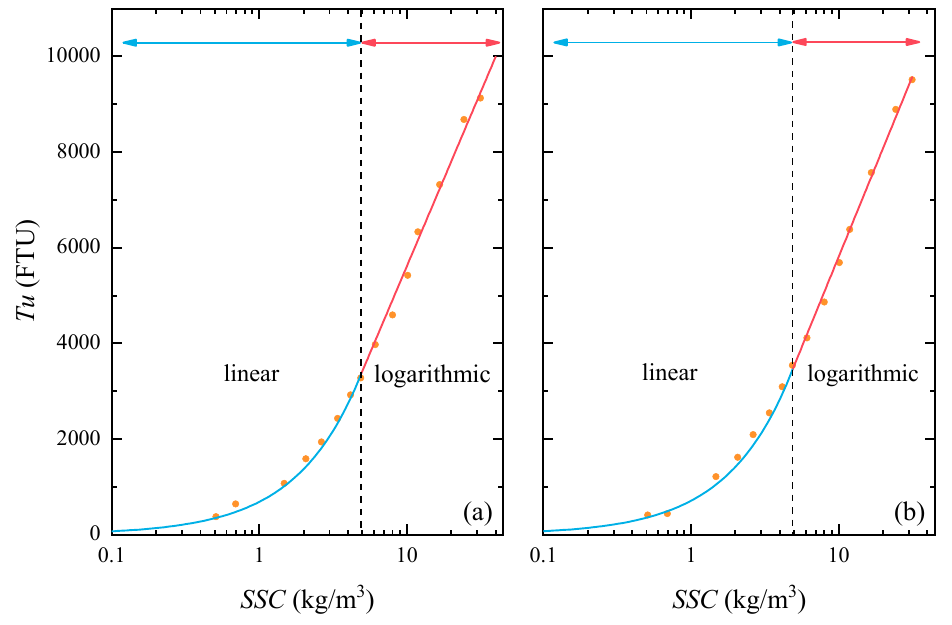
Figure 4. Laboratory calibration for 310TY on the tripod showing the response of Tu to SSC of the lab samples: ( a ) 0.1m asb; ( b ) 0.2 m samples: ( a ) 0.1m asb; ( b ) 0.2 m asb.